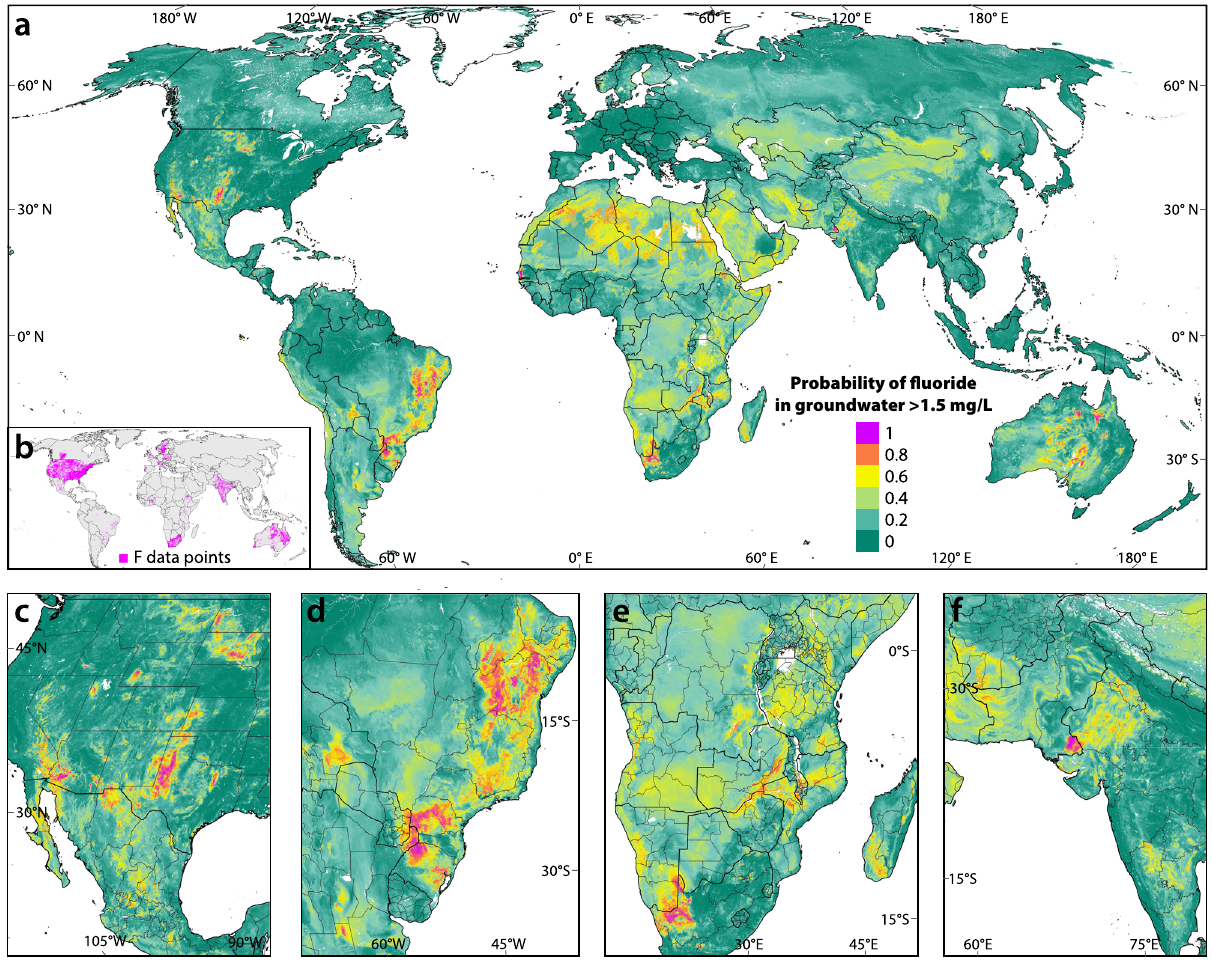
Fig. 1 Fluoride in groundwater. a Probability of naturally occurring fl uoride in groundwater exceeding the WHO drinking water guideline of 1.5 mg/L. The map was developed by applying the fi nal random forest model to the 12 most statistically important predictor variables. Panel b shows the fl uoride data points ( n = 402,452) used in analysis and modeling. Closer views of the global map are given for the western U.S. and Mexico ( c ), eastern South America ( d ), the southern half of Africa ( e ), and western South Asia ( f ). The data sources are listed in Supplementary Table 1 and a large-scale map of the fl uoride points is shown in Supplementary Fig. 1 along with large-scale versions of the prediction map focused on each continent in Supplementary Figs. 3 – fi gure show the relative importance of the model using only spatially continuous variables, whereas the blue columns indicate